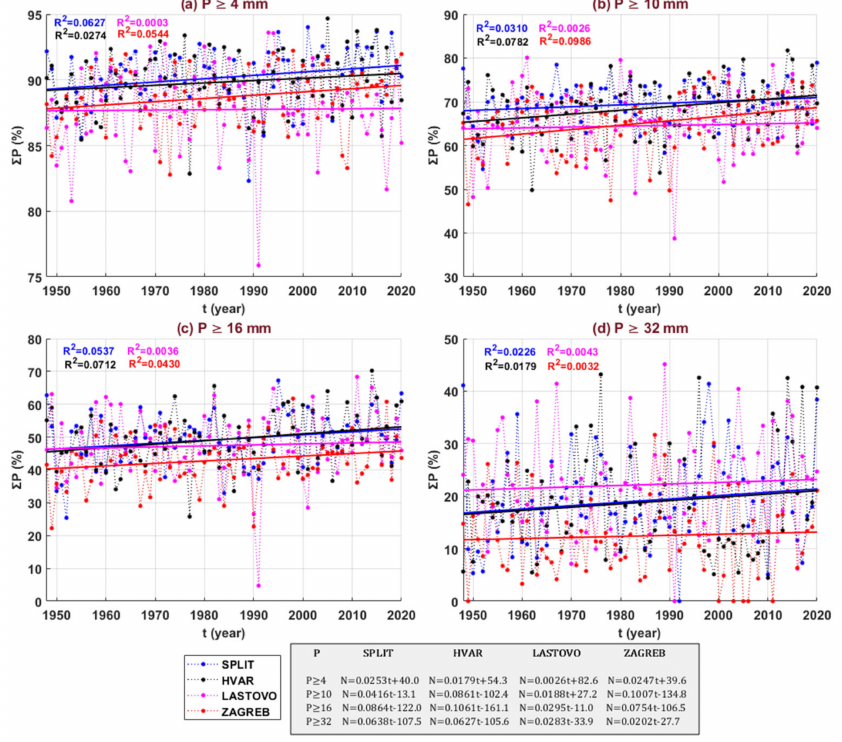
Figure 7. Time series of the sum of the percent of precipitations in a year, Σ P%, with